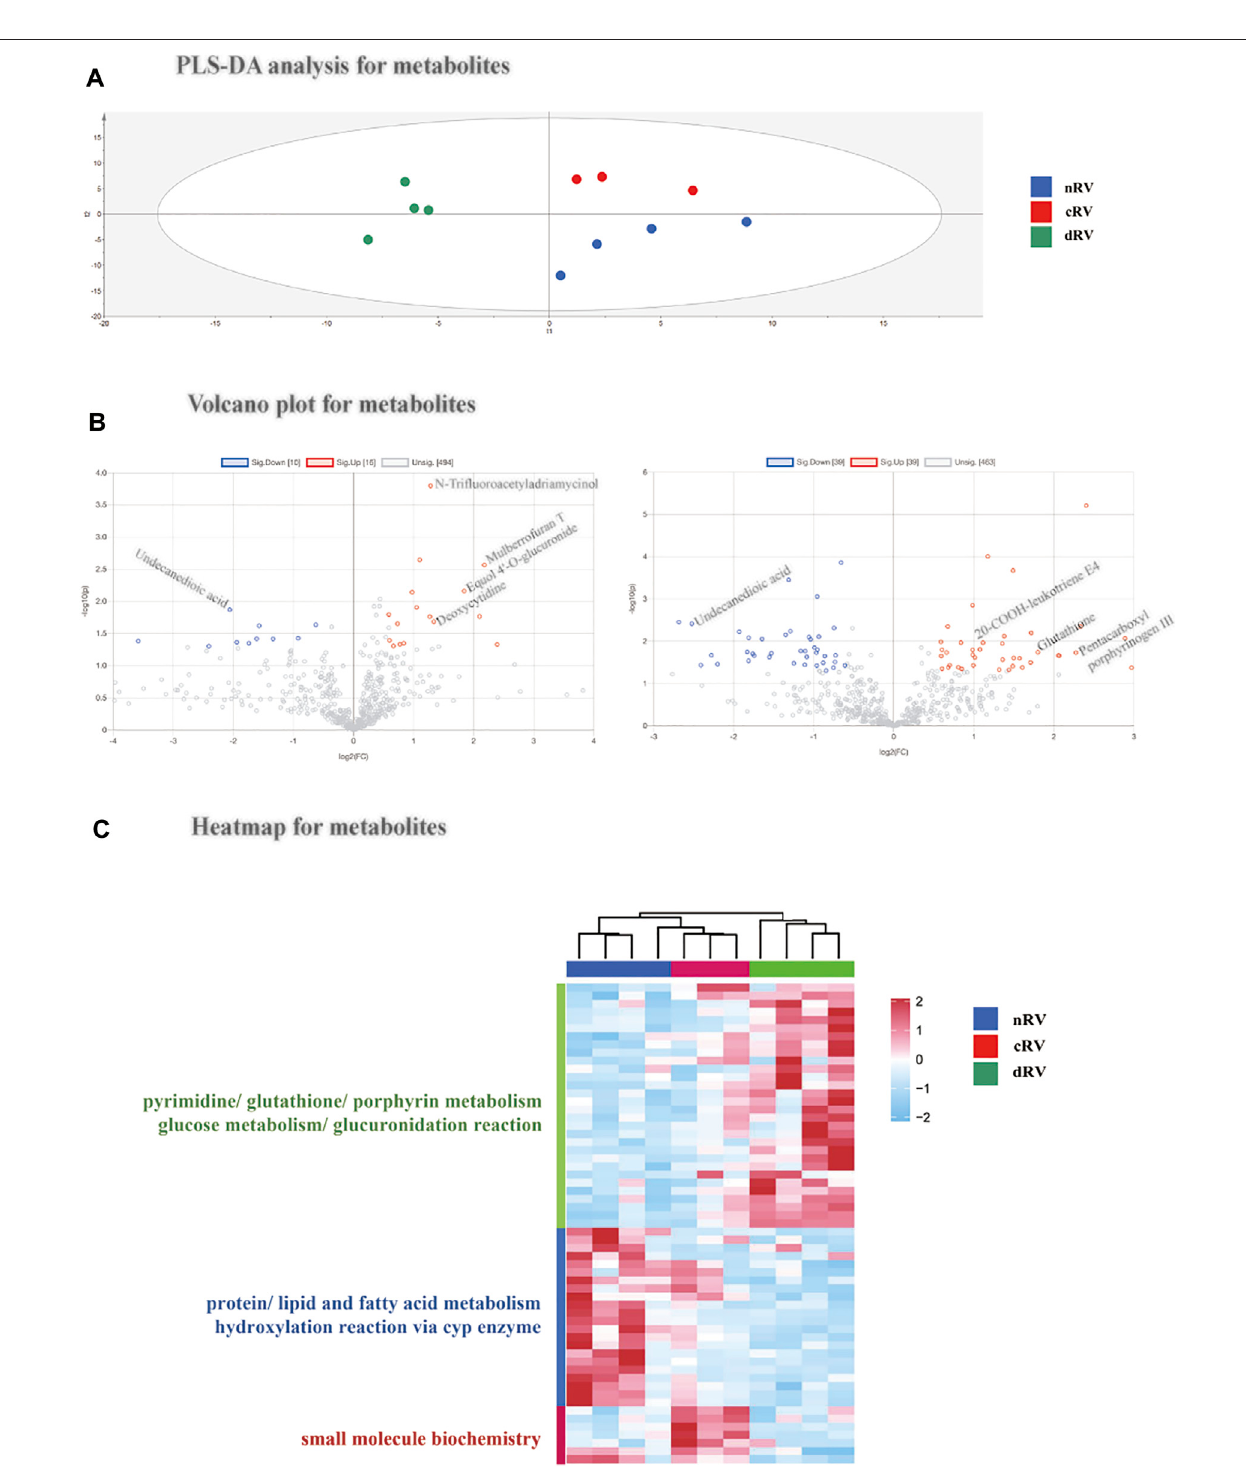
FIGURE4| RVFmetabolomicanalysisofthepresentstudy. (A) Thepartialleastsquaresdiscriminantanalysis(PLSDA)scoreplotbasedonthequanti fi cationofthe myocardial metabolome from nRV rats (blue), cRV rats (red), and dRV rats (green). (B) The volcano plots of the identi fi ed metabolites between cRV – nRV (left) and dRV – nRV (right). (C) The hierarchical clustering based on the quanti fi cation of altered metabolites among different stages and their function annotation.